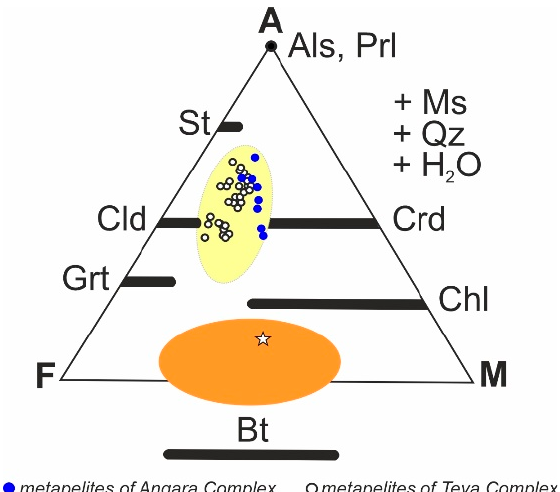
Figure 20. AFM diagram projected from muscovite, quartz, and water schematically showing the positions of common (typical) metapelites (dark-gray ellipsis elongated in the F–M direction, below the Grt-Chl tie line) and highly aluminous pelites and other related aluminous rock types (dark-gray ellipsis elongated towards the A top, above the Grt-Chl tie line). A = Al 2 O 3 − 3K 2 O; F = FeO, M = MgO. Asterisk denotes the average composition of typical metapelites after Ague [105].